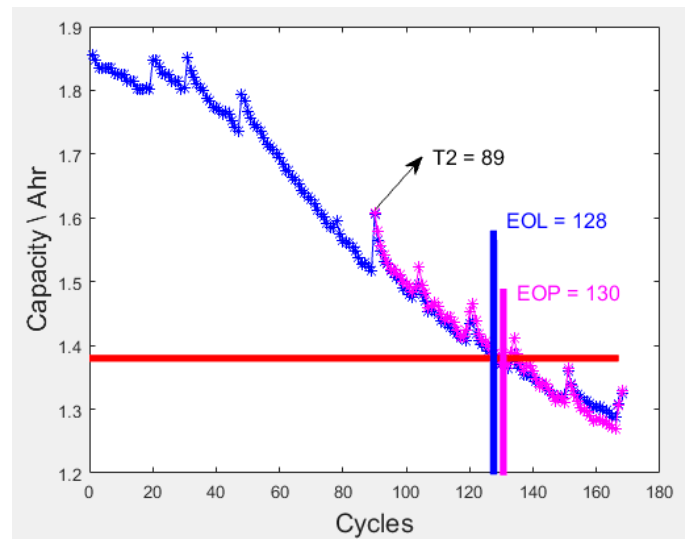
Figure 9. The prediction result of LSTM at T2 = 89.